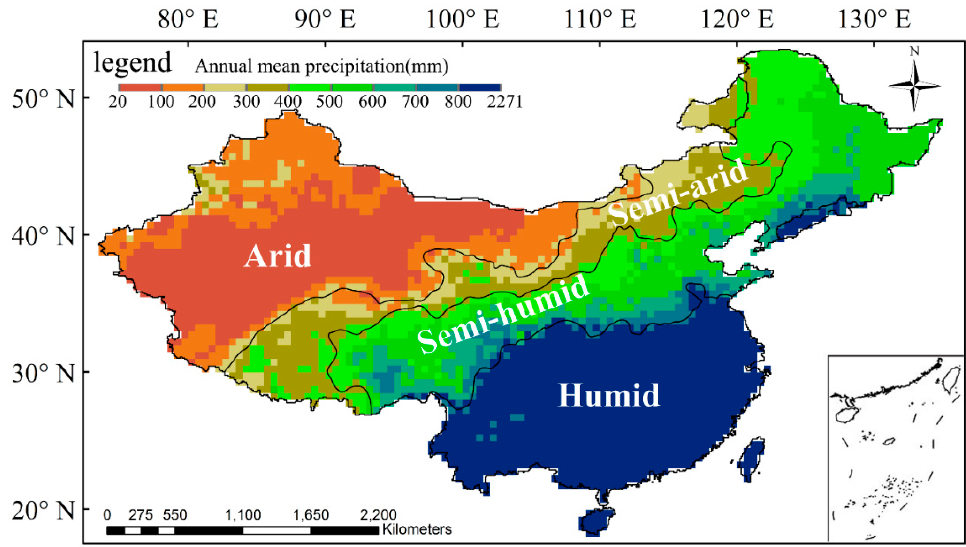
Figure 1. Map showing the distribution of four climate regions based on the annual mean precipitation (1961–2005) over China. Table 1. Information on the 8 general circulation models.